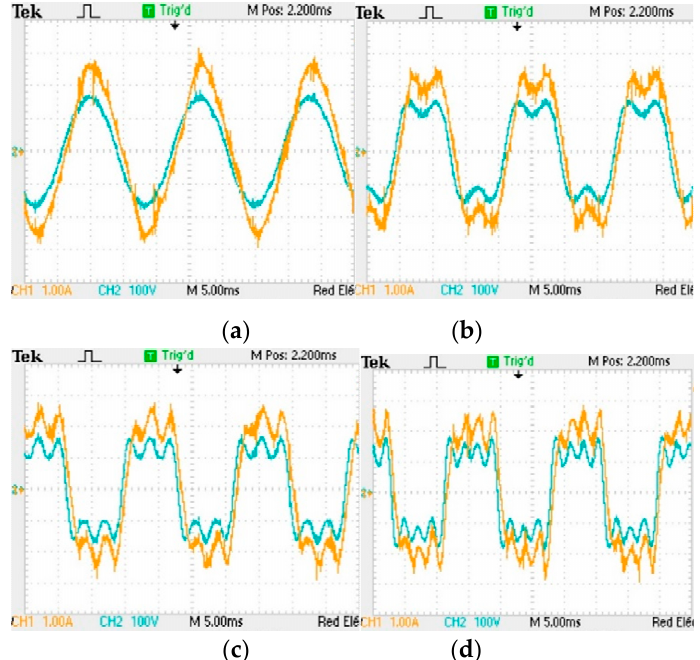
Figure 9. Voltage (green) and current (orange) signals: ( a ) fundamental; ( b ) fundamental + 3rd harmonic; ( c ) fundamental + 3rd + 5th harmonic; ( d ) fundamental + 3rd + 5th + 7th harmonic.